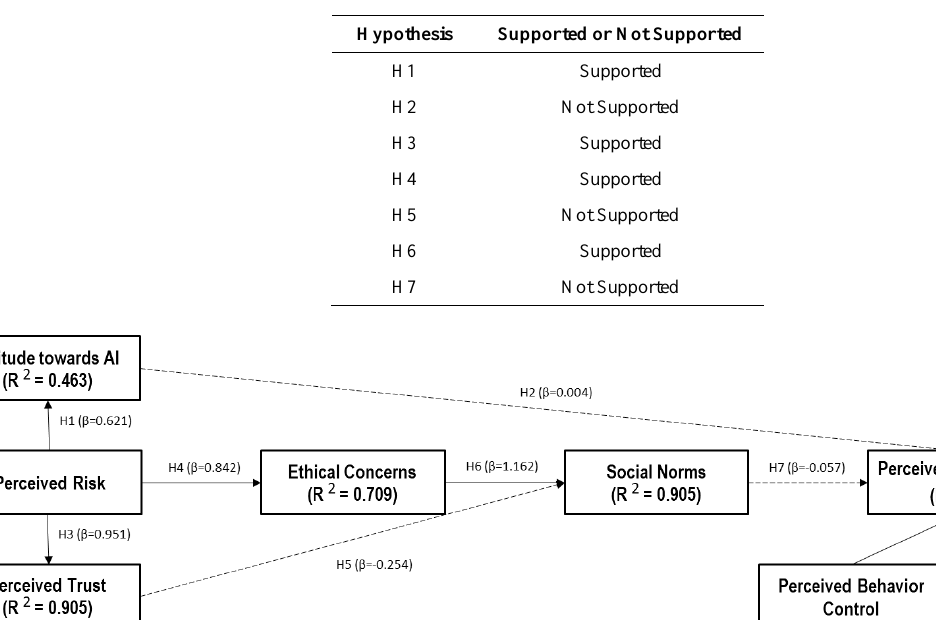
Table 11. Summary of hypothesis results